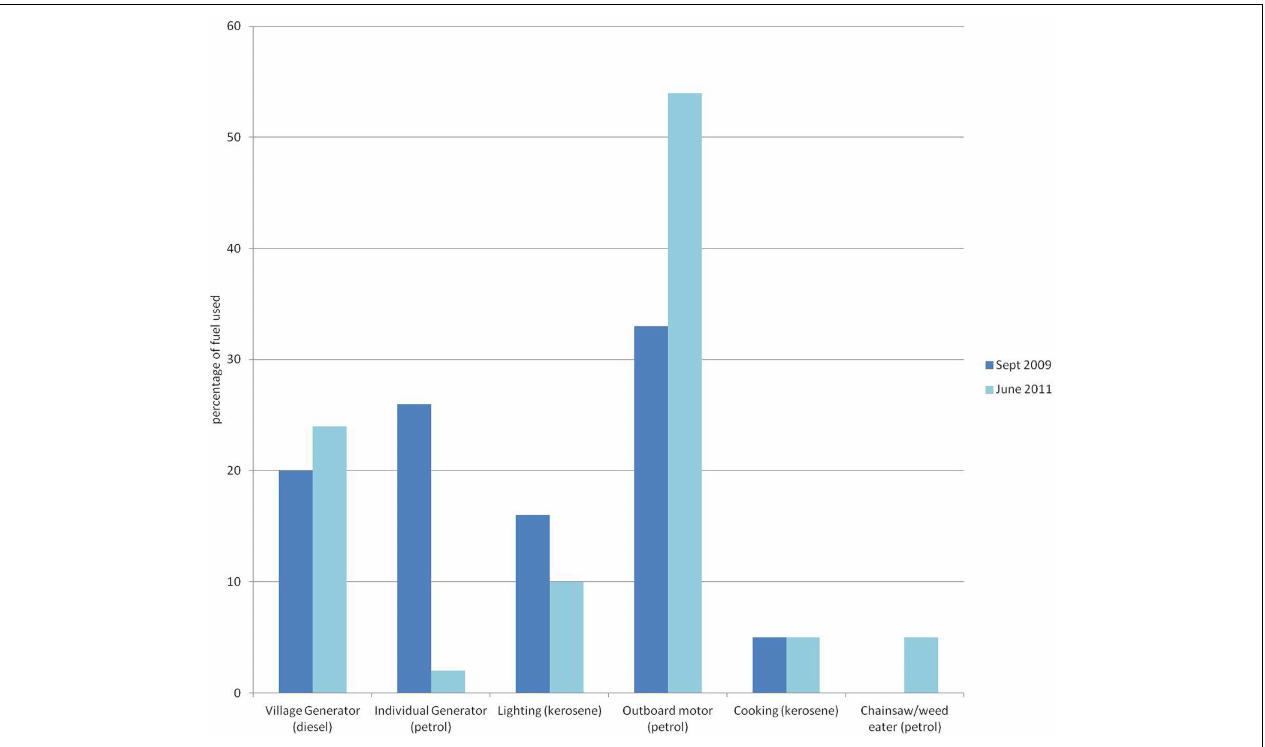
FIGURE 4 | Village fuel use